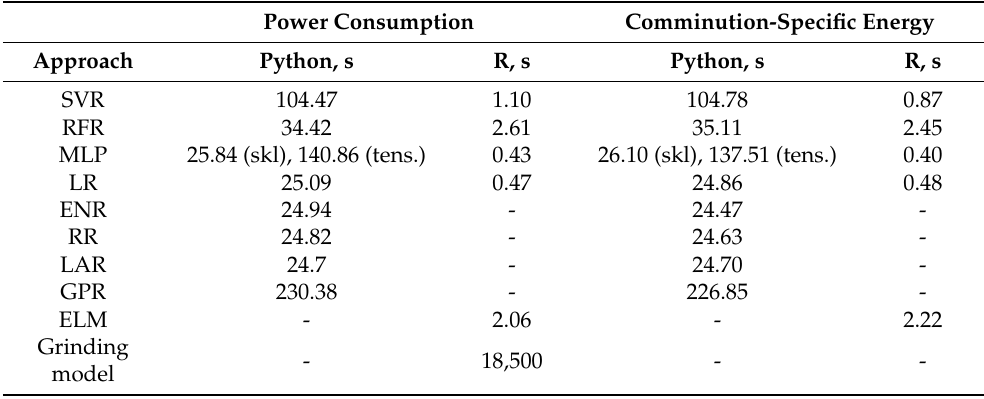
Table 3. Execution time for the Sobol–Jansen method using SMs and SAG